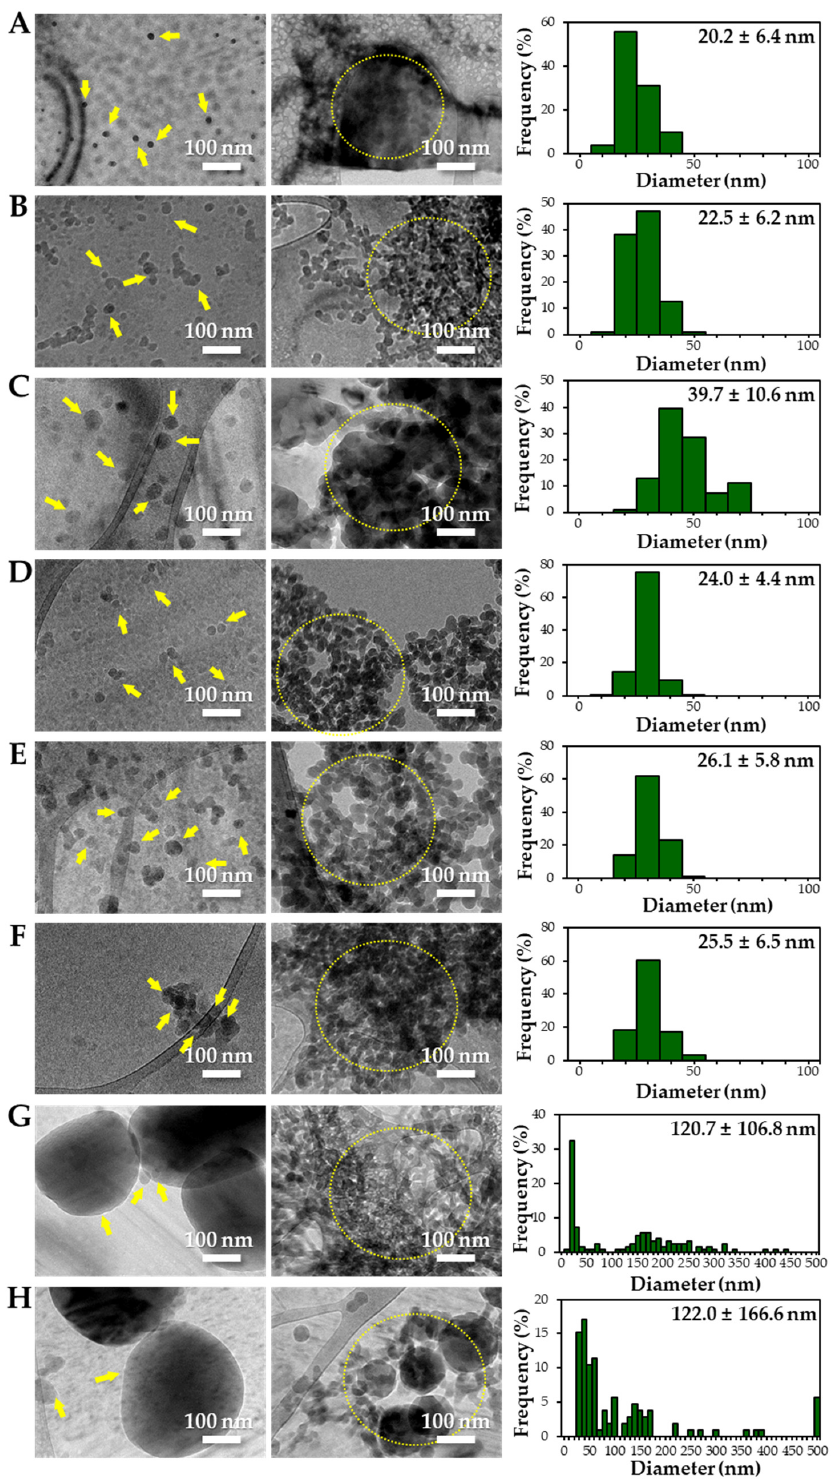
Figure 2. Cryogenic transmission electron microscopy (cryo-TEM) images and size distributions of TD-NPs or conventional BP-1 and BP-2 composed of the same components as NP-1 and NP-2, respectively. ( A ) NP-1, ( B ) NP-2, ( C ) NP-3, ( D ) NP-4, ( E ) NP-5, ( F ) NP-6, ( G ) BP-1, and ( H ) BP-2. Yellow arrows and yellow dotted lines indicate separated individual particles and aggregated forms, respectively. Particle size distributions were determined by randomly selecting more than 100 particles from the cryo-TEM images. Abbreviations: TD-NP, top-down-approach-produced nanoparticle; BP, bulk-sized particle; NP,